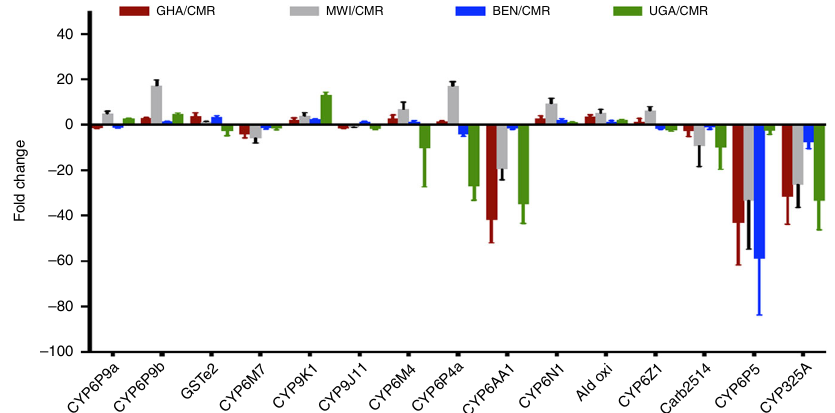
Fig. 1 Comparative transcription pro fi les of An. funestus between countries. qRT-PCR comparison of the expression pro fi le of major detoxi fi cation genes associated with pyrethroid resistance between populations of An. funestus from different African regions supporting a shift in the role of these genes between regions. The data shown are mean + SEM ( n = 3). Source data are provided as a Source Data